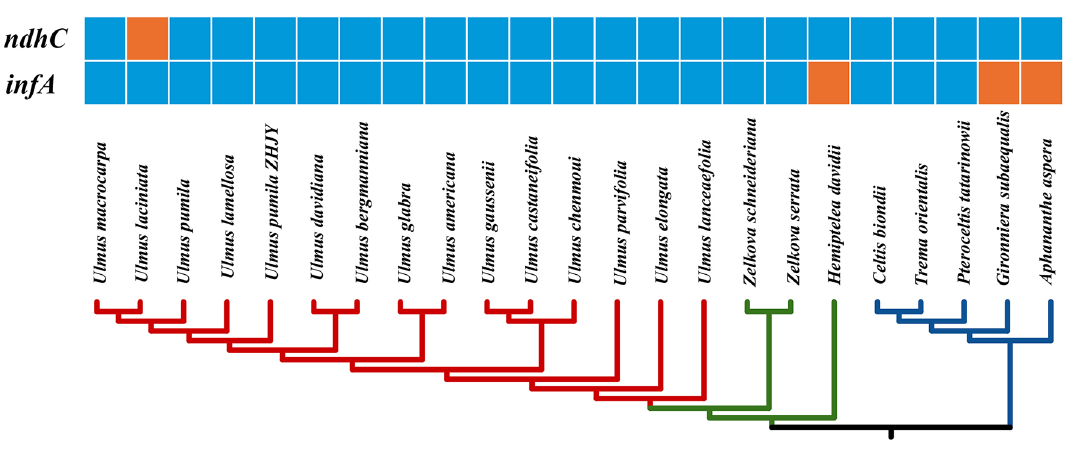
Figure 5. Loss of chloroplast protein-coding genes in the phylogeny of 23 Ulmaceae